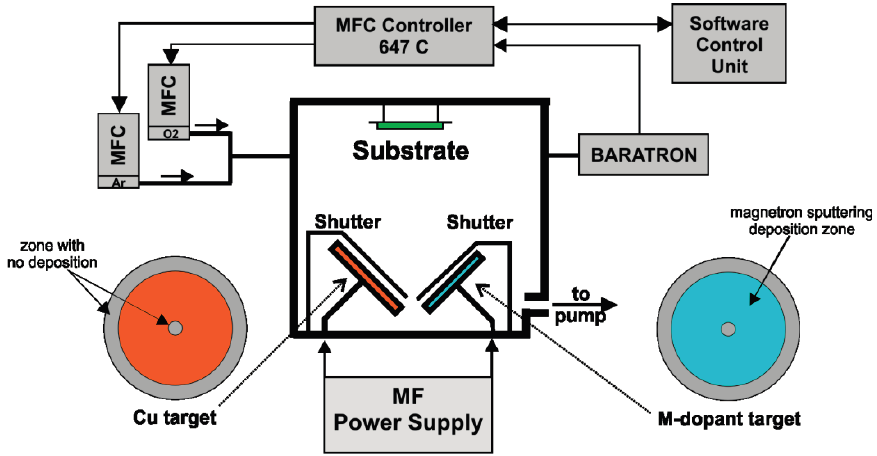
Figure 1. Schematic view of the medium frequency (MF) magnetron co-sputtering system with 50-mm magnetron targets.